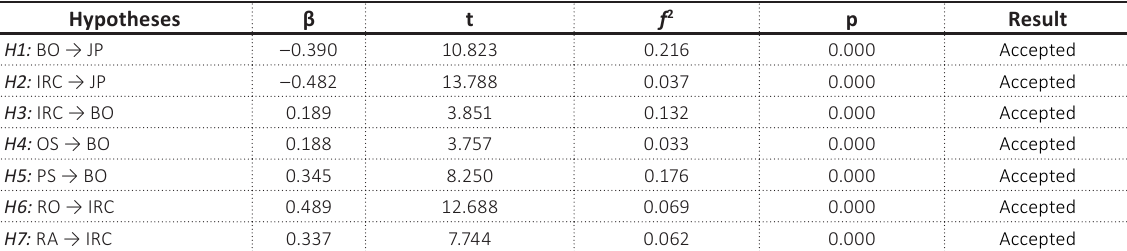
Table 5. Hypotheses testing